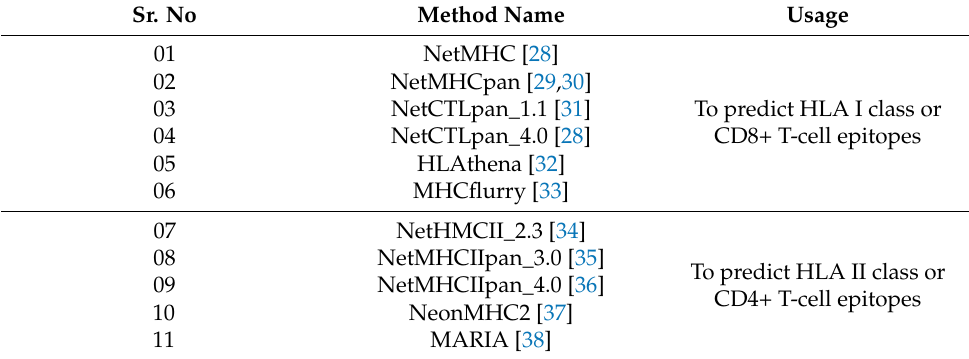
Table 1. Existing methods for T-cell epitope